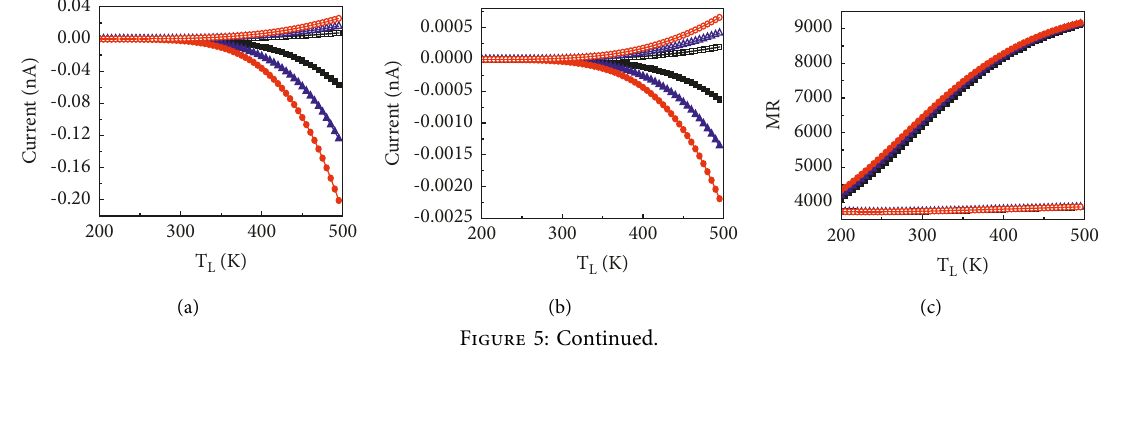
Figure 4: The thermally driven spin-related currents I up and I dn in the thermal spin devices ( R (cid:31) CONH) with respect to T L and (d) closed state; (b) and (e) open state. (c) and (f) the thermal spin devices’ switching ratio versus T L and ∆ T ,